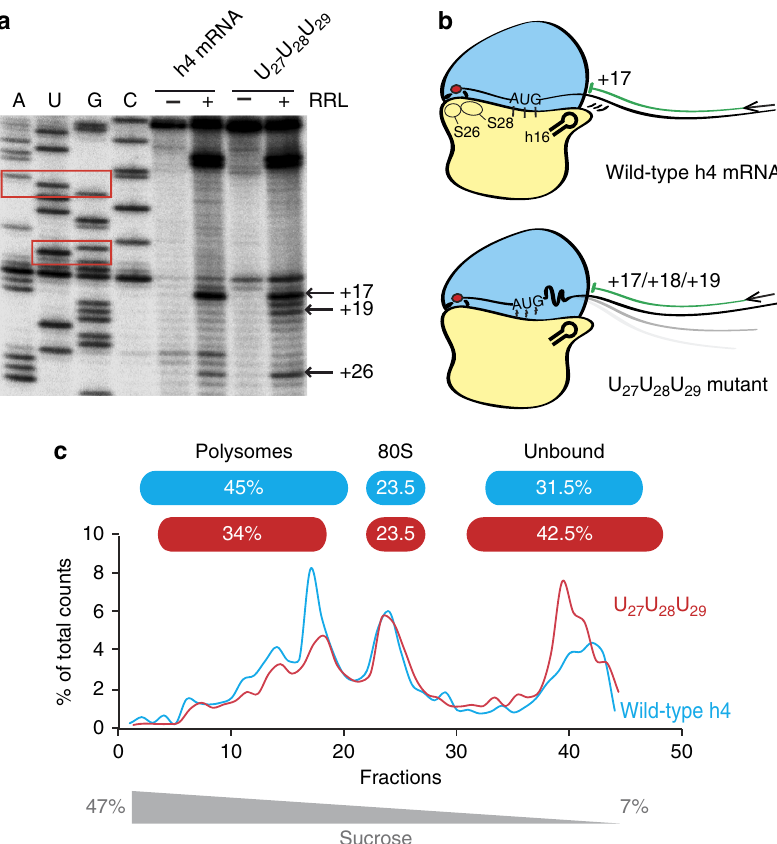
Figure 2 | Ribosome toe-prints and polysome fractionation with h4 mRNA and mutant. ( a ) Initiation complexes were assembled in RRL extracts in the presence of cycloheximide and hygromycin B to stall the initiation complexes on the AUG codon. Reaction samples were separated on 8% denaturing PAGE together with the appropriate sequencing ladder (shown on the left). AUG initiation codon and GUG codon are boxed. Toe-print positions were numbered starting on the A of the AUG codon ( þ 17 position corresponds to h4 nt 27). ( b ) Model of h4 interaction within the 80S ribosomal particle. Accurate positioning of h4 mRNA results from interactions with helix h16 from 18S rRNA. Mutation of nts 27–29 induces toe-print shifts to þ 18 and þ 19 indicating that the mRNA is not accurately maintained into the mRNA channel. ( c ) Polysome fractionation of translation extracts programmed with wild-type h4 mRNA and derived triple mutant. Ribosome assembly and translation was studied in RRL programmed with 5 0 -end radiolabelled m 7 G-capped h4 mRNA. Unblocked translation extracts were separated on 7–47% sucrose gradients and radiolabelled mRNAs were detected by Cerenkov counting. The graph represents the radioactivity in the different fractions expressed as a percentage of the total radioactive counts. The positions of polysomes, 80S and free mRNA are indicated. The sums of counts measured in polysomes, 80S particles and not assembled (unbound) are indicated in the blue and red bars for wild-type and triple mutant,